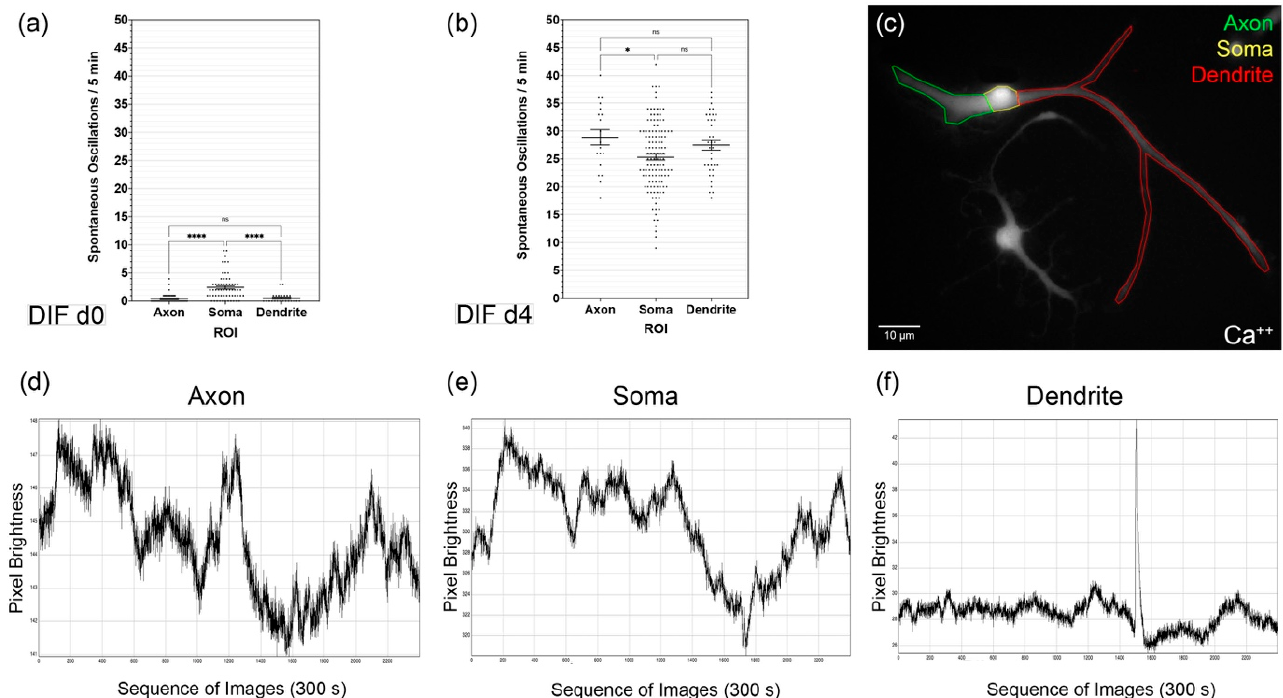
Figure 2. Analysis of spontaneous calcium oscillations in different CN NSC subregions of the cells: ( a ) Spontaneous calcium oscillations in axons, somata, and dendrites from DIF d0 and DIF d4 ( b ) over 5 min. Results are shown as mean ± standard error of the mean. ( c ) Representative photomicrograph in the calcium imaging analysis of NC NSCs with the labeling of different regions of interest (ROI). ( d – f ) Representative data of calcium imaging sequences in the corresponding ROI. The individual fluorescence intensity values of Oregon Green ® /Ca 2+ as dimensionless values over 300 s/5 min are shown. * p < 0.05 and **** p < 0.0001, ns = not significant.